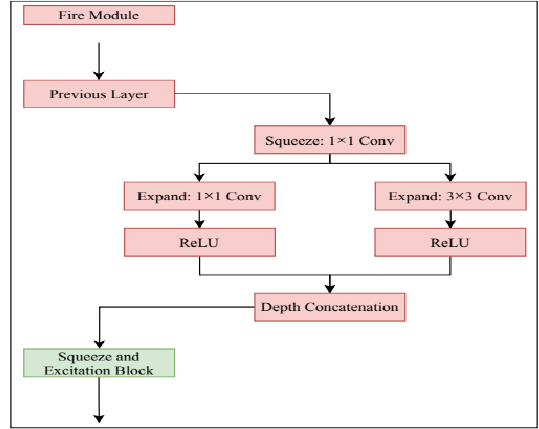
Figure 7. Fire Module .